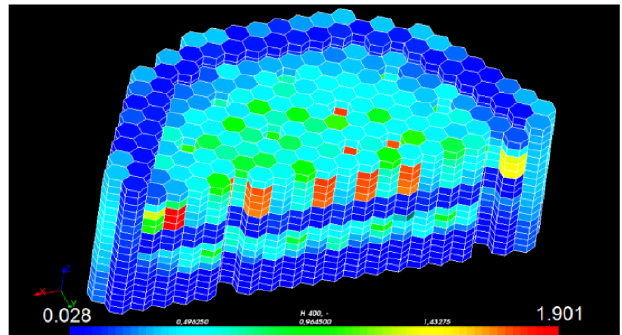
Fig. 6. Typical 3D map of H gap (W/cm 2 /K).